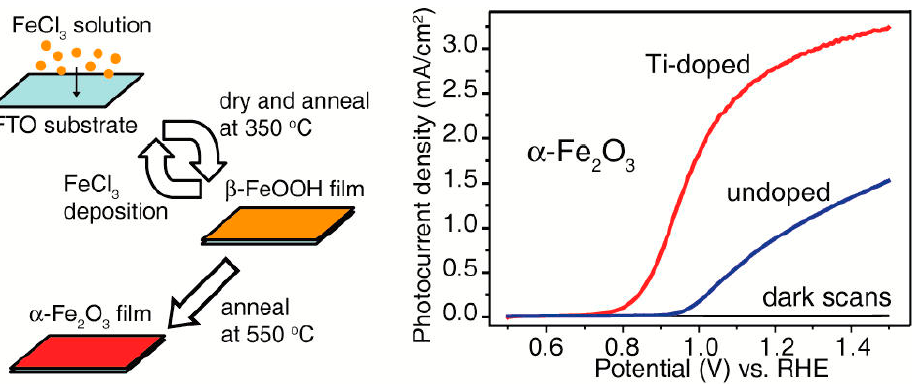
Figure 2. Synthesis process of deposition-annealing ( left ) and the J-V scan of the undoped and Ti-doped hematite photoaondes ( right ). Adapted with permission from [39]. Copyright 2011 American Chemical Society.